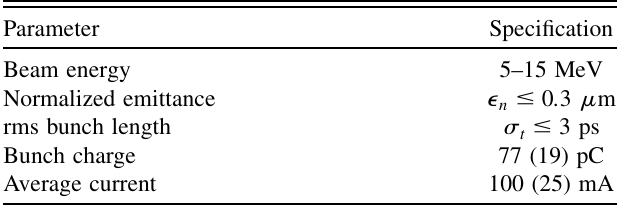
TABLE I. List of injector design specifications and target